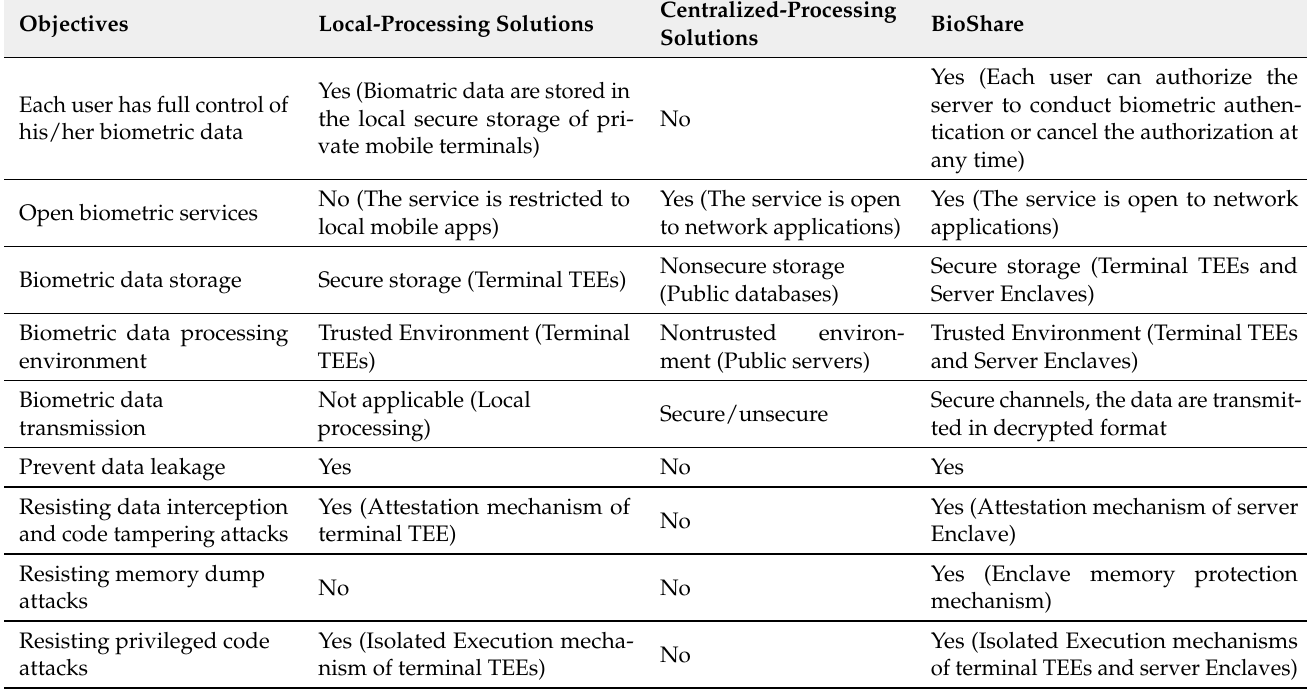
Table 12. Security Properties of Terminal TEE and Server